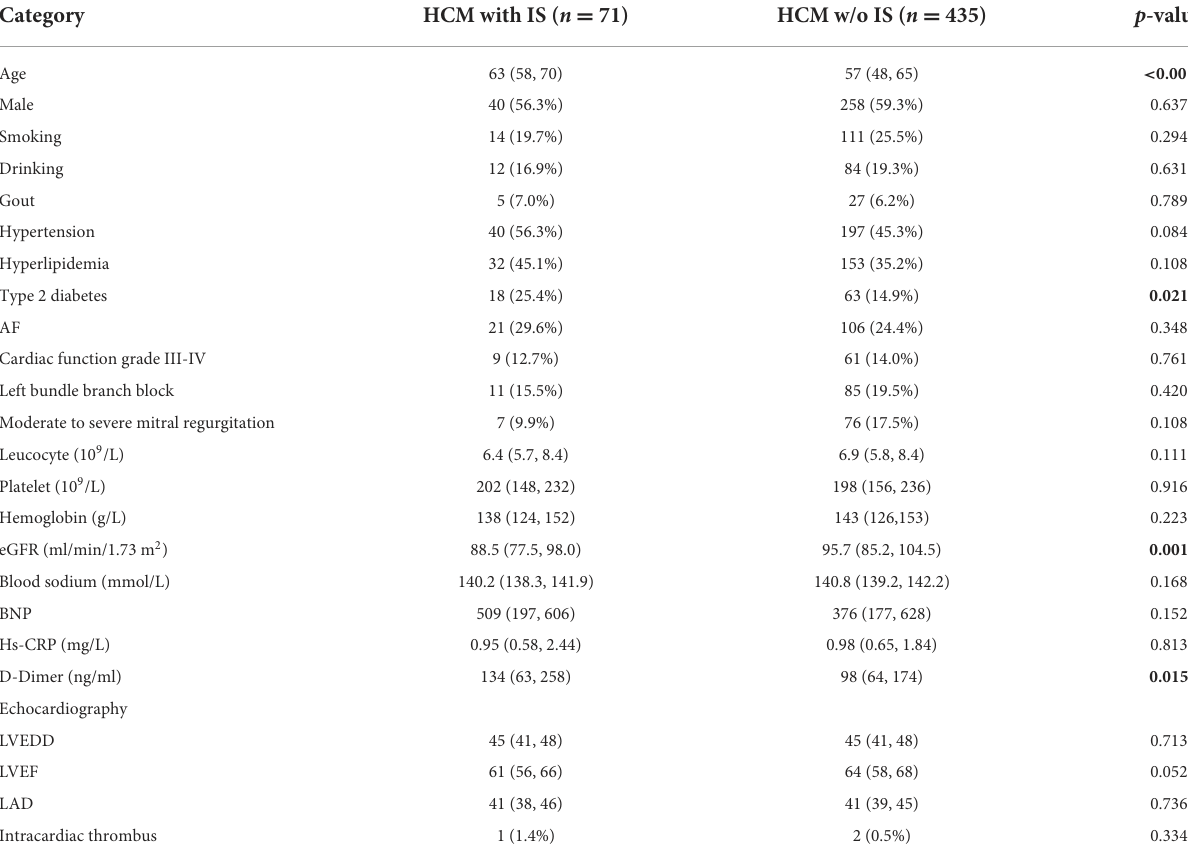
TABLE 1 Comparison of baseline data in patients with hypertrophic cardiomyopathy (HCM) complicated with or without ischemic stroke (IS). Category